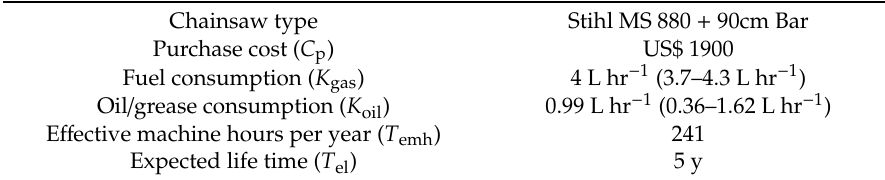
Table 3. Machinery data ([35],